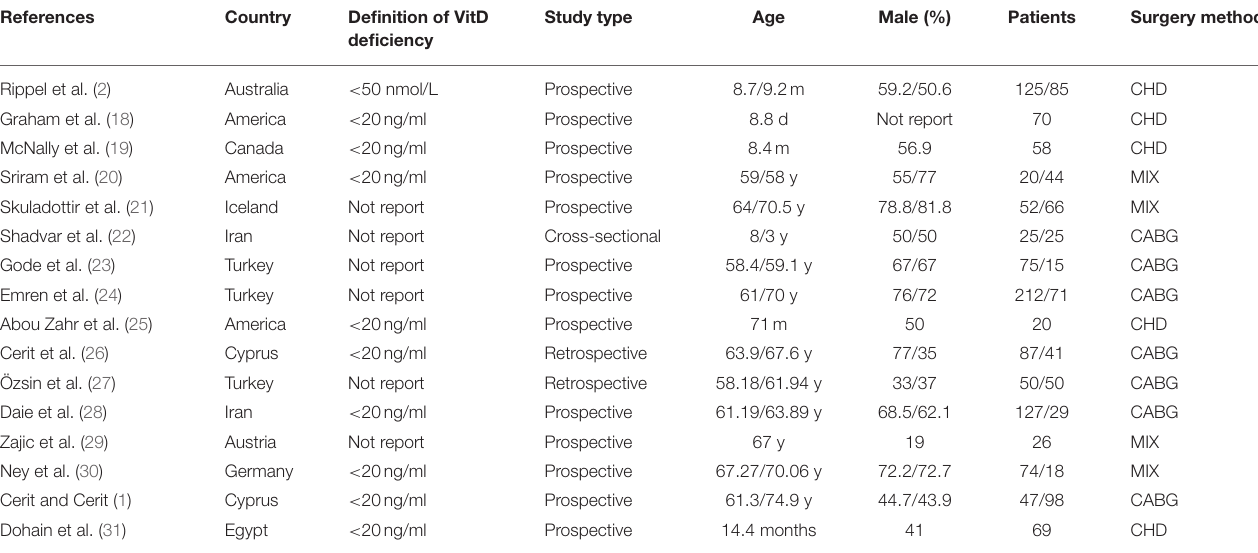
TABLE 1 | Characteristics of involved patients with cardiac surgery in all included